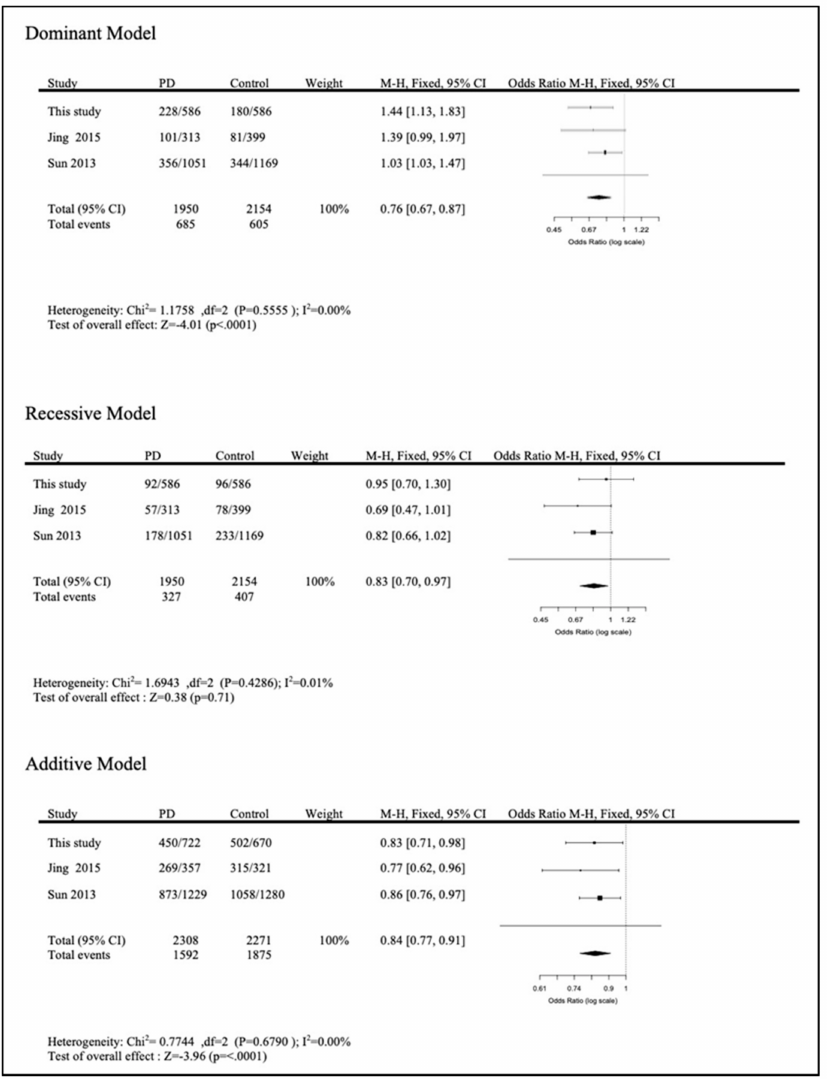
Figure 2. Meta-analysis of different